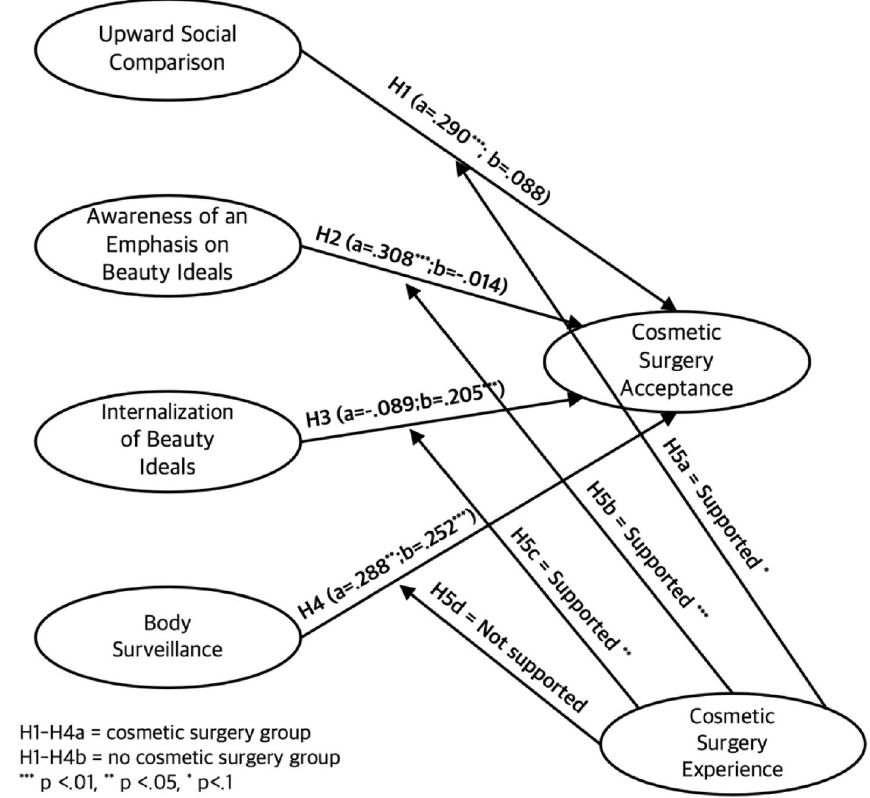
Fig. 2 Results of hypothesis